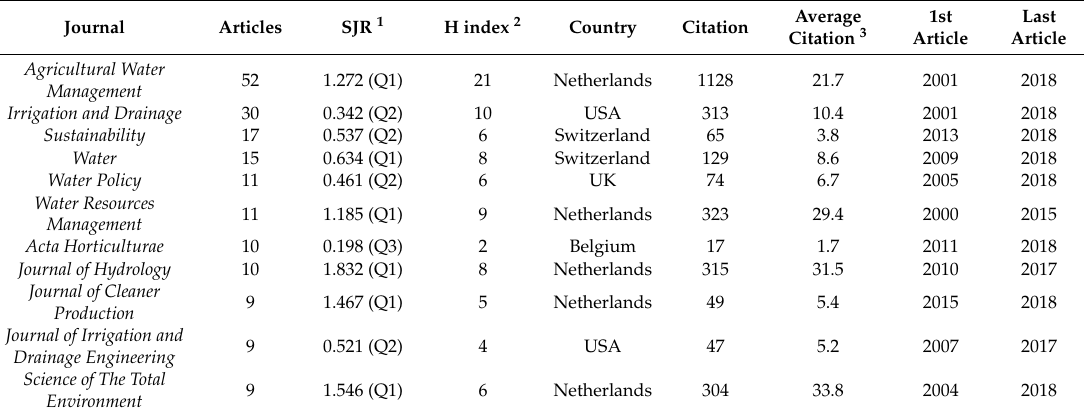
Table 2. Main characteristics of the most active journals related to SI research.